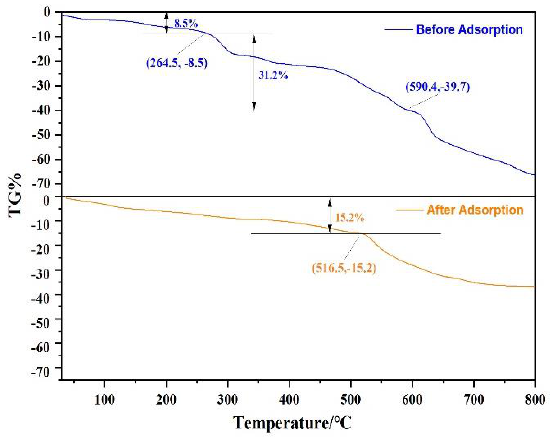
Figure 9. The TGA curve of Fe 3 O 4